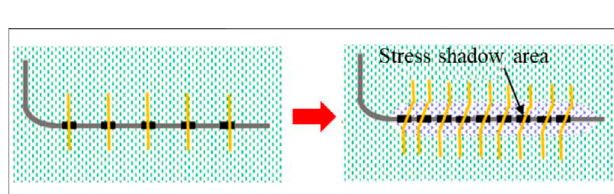
FIGURE11 | Diagram offracture diversion in horizontal well